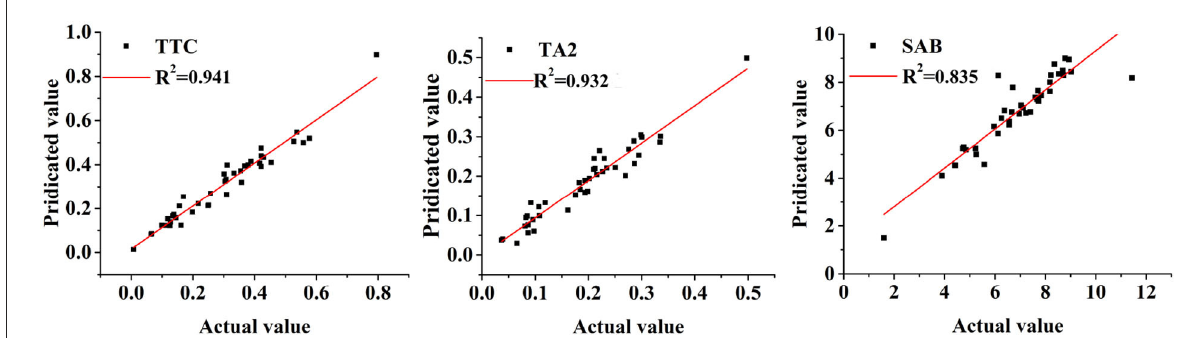
FIGURE10 The correlation diagrams of the NIR predicted and HPLC-DAD data regarding three quality indicators (Description: TTC represents the total of tanshinone IIA, tanshinone I, and cryptotanshinone; TA2 and SAB represents the compounds of tanshinone IIA and salvianolic acid B, respectively. As seen from this figure, these observations are evenly distributed on both sides of the correlation equation, indicating these models are effective to predict these quality